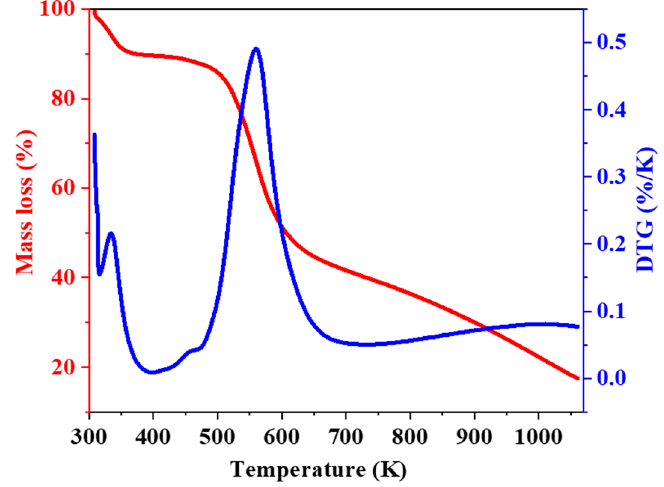
Figure 4. Thermogravcimetric (red line) and derivative curves (blue line) for chemically modified CH-AN bio-composite.